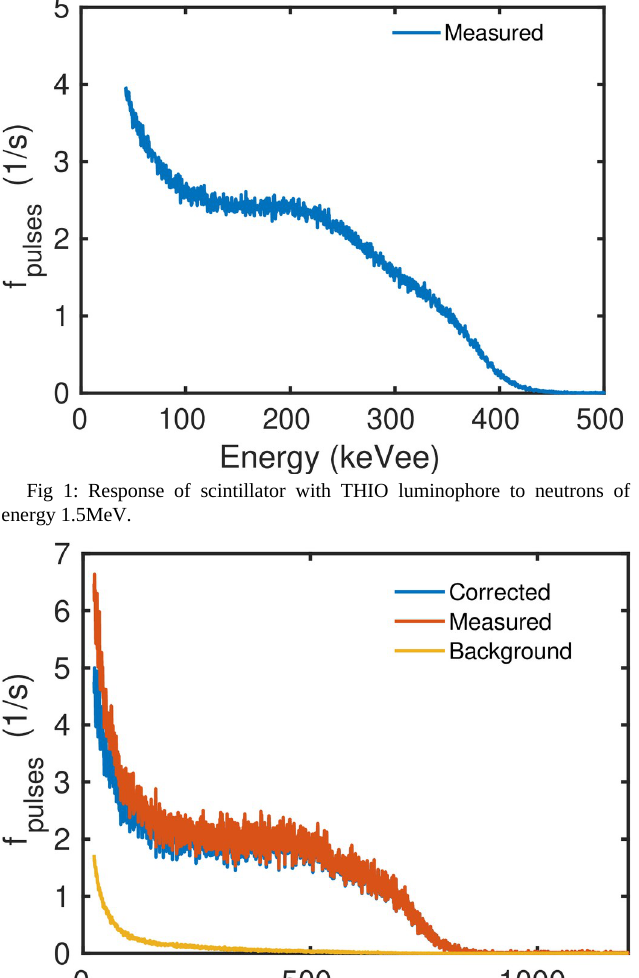
Fig 4: Response of scintillator with PYR luminophore to neutrons of energy 2.5